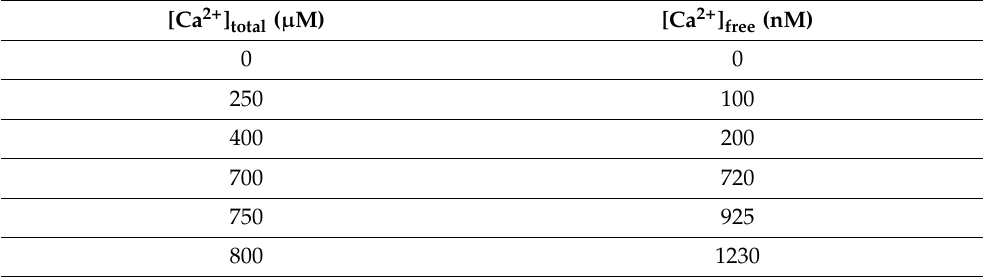
Table 2. Conversion between total Ca 2+ concentrations ([Ca 2+ ] total ) added to the buffer and free Ca 2+ concentration ([Ca 2+ ] free ). Conversions were made based on Ca 2+ chelator calculations [68]. The experimental conditions are: EGTA = 1 mM, ionic strength 0.17, pH 7.2, temperature 37 ◦